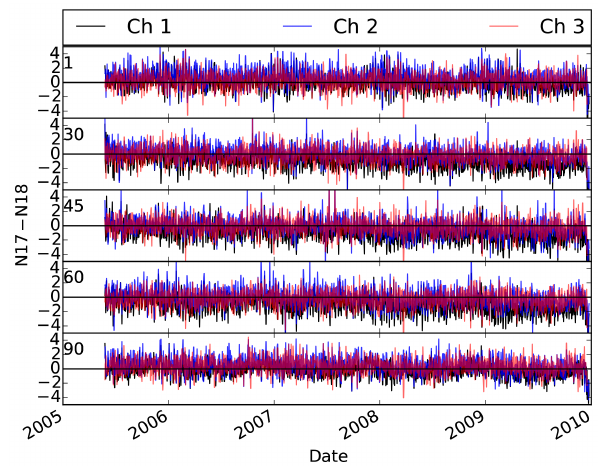
Figure 5. Effect of polarization on the difference between NOAA- 17 AMSU-B and NOAA-18 MHS observations for different FOVs over tropical land. FOV numbers are printed on the left side of each